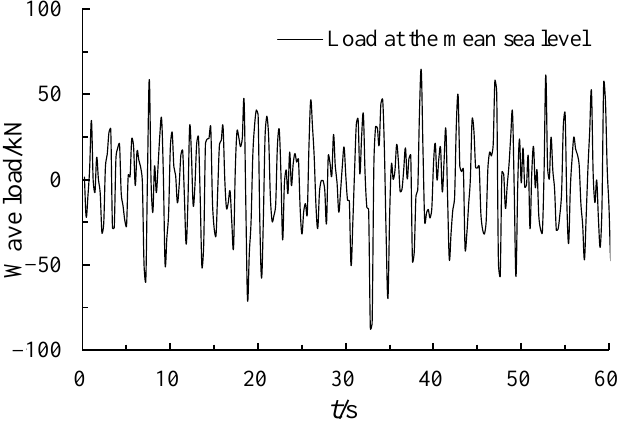
Figure 17. Wave load at the mean sea level.